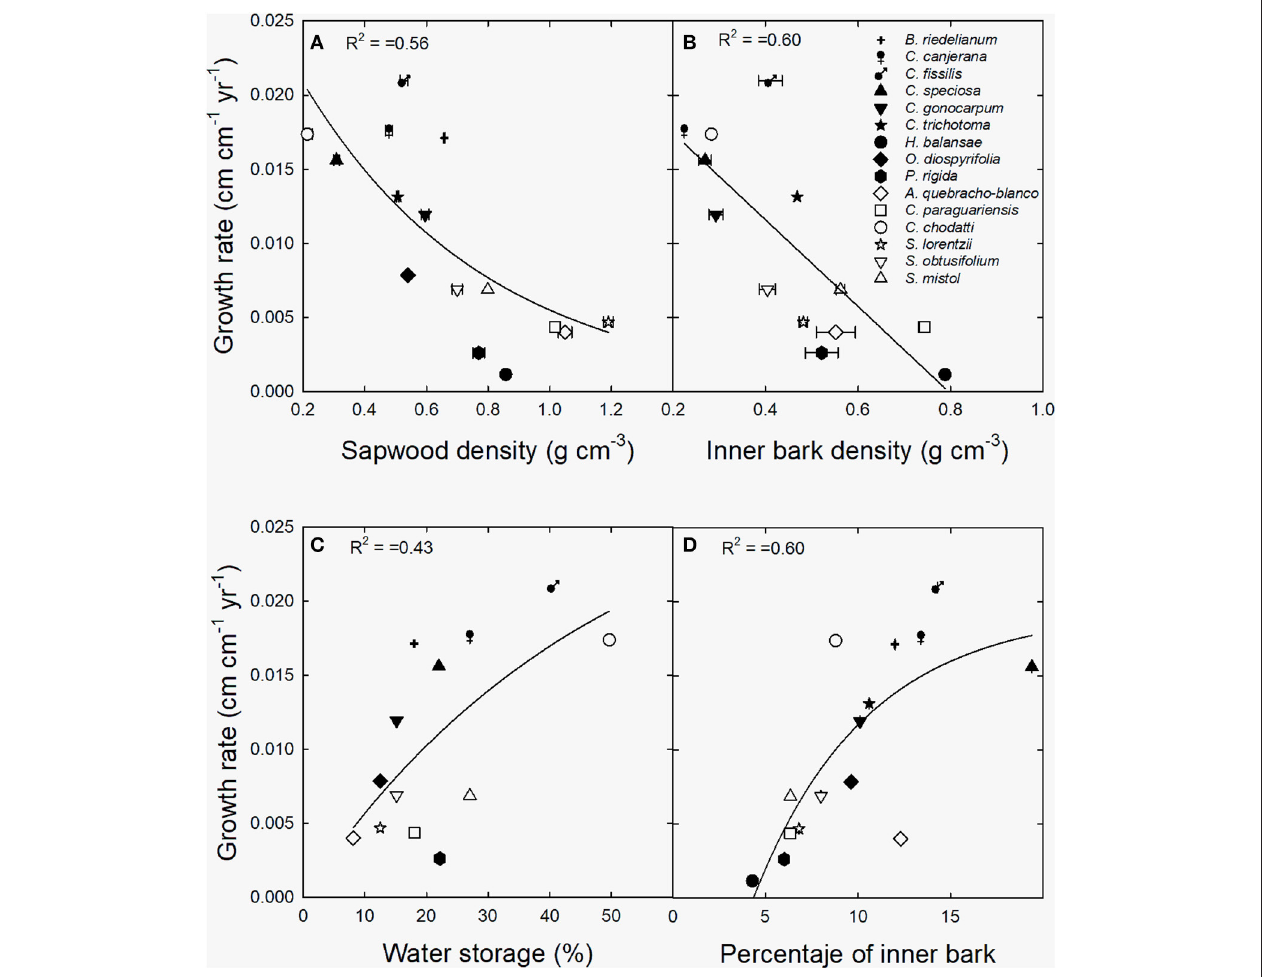
FIGURE 6 | Relationship between growth rate and (A) sapwood density, (B) inner bark density, (C) contribution of water storage to daily transpiration (water storage) and (D) percentage of inner bark. Black symbols correspond to wet extreme and white symbols to dry extreme. The lines are the functions fitted to the data [ (A) y = 0.38 + 2.8 exp − 0.83x , p < 0.0001; (B) y = 0.023–0.029x, p < 0.01; (C) y = 0.03*(1-exp − 0.021x ), p < 0.001; (D) y = − 0.020 + 0.039*(1–exp − 0.16x ), p <